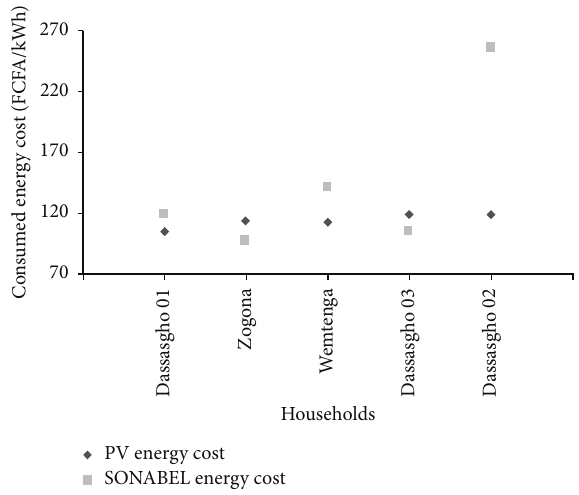
Figure 7: PV and SONABEL consumed energy costs. Households ranged from the highest energy consumption to the lowest one, like PV energy’s expected